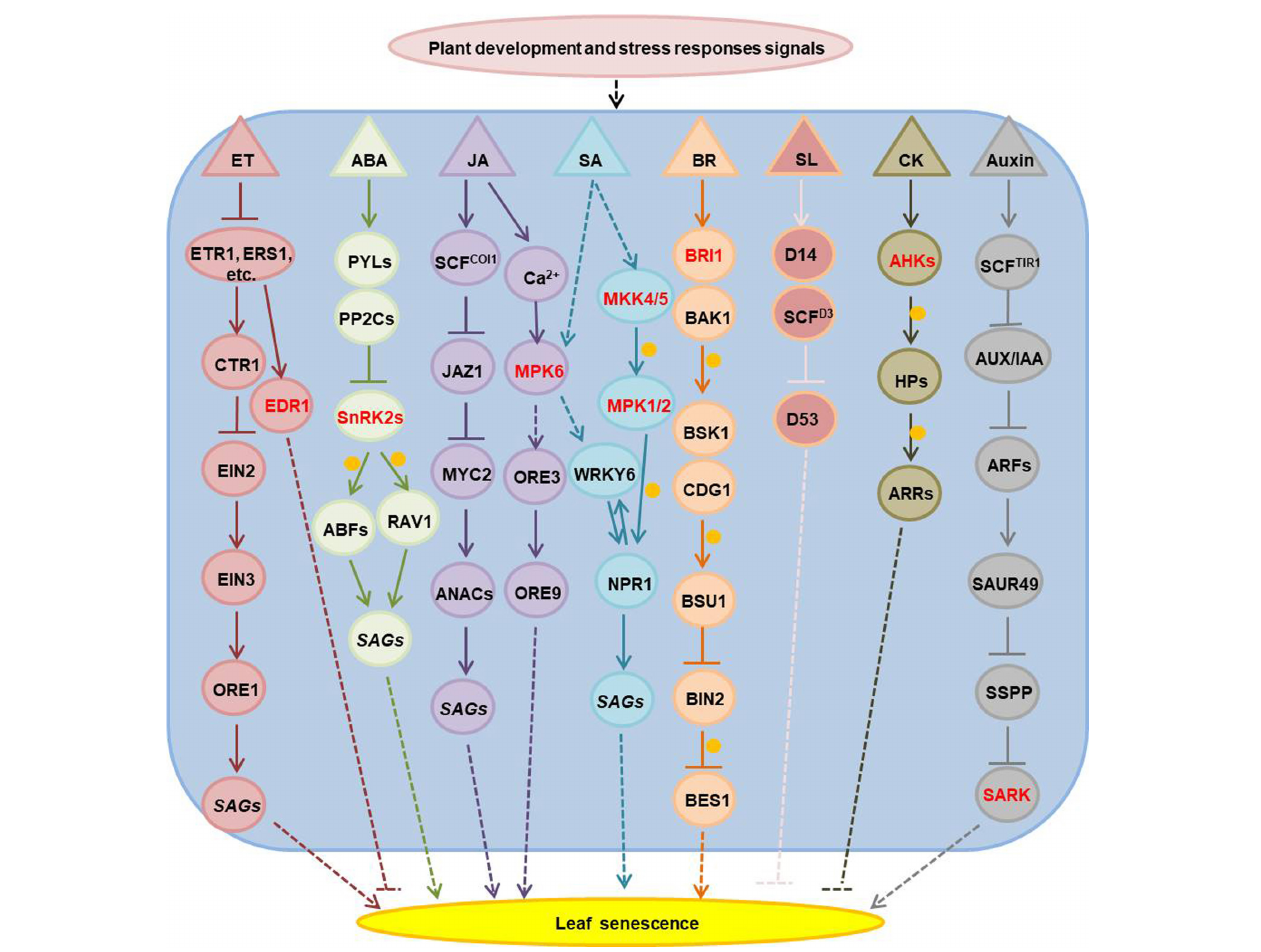
FIGURE 1 | The senescence-associated kinases functioned in hormones-regulated leaf senescence. The kinases are marked with red; arrows show that the process is promoted, and T-bars mean the process is inhibited; the solid lines indicate direct reported relationship, and the dotted lines indicate indirect reported relationship; the orange circles indicate phosphorylation. ET, ethylene; ABA, abscisic acid; JA, jasmonic acid; SA, salicylic acid; BR, brassinosteroids; SL, strigolactone; CK, cytokinins; ETR1, ethylene response 1, it is one of the five ET receptors; ERS1, ethylene response sensor 1, one of ET receptors; CTR1, constitutive triple response 1, homologous to the RAF family of serine/threonine protein kinases, a negative regulator in the ethylene signal transduction pathway, it interacts with the putative ethylene receptors ETR1 and ERS1; EIN2, ethylene insensitive 2, it acts downstream of CTR1 to regulate EIN3 positively; EIN3, ethylene-insensitive 3, a nuclear transcription factor that initiates downstream transcriptional cascades for ethylene responses; ORE1, ORESARA 1, it is a NAC-domain transcription factor and regulates senescence in leaves positively; SAGs , senescence associated genes; EDR1, enhanced disease resistance 1, a RAF family of serine/threonine protein kinases like CTR1, it has a negative role in ET signal pathway; PYLs, pyrabactin resistance 1-like family proteins, function as the ABA receptors; PP2Cs, the type 2C protein phosphatases, function as ABA co-receptors; SnRK2s, sucrose non-fermenting 1-related protein kinase 2 family proteins, they are activated by ABA and inhibited by PP2Cs; ABFs, ABA responsive element binding factor proteins, as leucine zipper transcription factors that bind to the ABA-responsive element (ABRE) motifs in the promoter region of ABA-inducible genes; RAV1, related to ABI3/VP1 1, an AP2/B3 domain transcription factor which is upregulated in ABA-induced leaf senescence; COI1, coronatine insensitive 1, JA receptor, it associates with AtCUL1, AtRbx1, and the Skp1-like proteins to assemble SCF COI1 ubiquitin-ligase complexes; JAZ1, jasmonate-zim-domain protein 1, it is degraded by SCF COI1 ubiquitin-ligase complexes under JA stimulus; MYC2, MYC-related transcriptional activator 2; ANACs, NAC domain-contained transcription factors; MPK6, mitogen-activated protein kinase (MAPK) 6; ORE3, ORESARA 3 or named as EIN2; ORE9, ORESARA 9, as a member of the F-box leucine-rich repeat family proteins, it is a proposed regulator of leaf senescence; MKK4/5, MAPK kinase 4/5; MPK1/2 (MAPK1/2), mitogen-activated protein kinase 1/2; BRI1, BR insensitive 1, encodes a plasma membrane localized leucine-rich repeat receptor kinase, as BR receptor; BAK1, BRI1-associated receptor kinase, as the BR co-receptor with BRI1, it is a leucine-rich receptor serine/threonine protein kinase; BSK1, BR-signaling kinase 1; CDG1, constitutive differential growth 1, is a receptor-like cytoplasmic kinase, belongs to RLCKVII subfamily; BSU1, BRI1 suppressor 1, encodes a serine-threonine protein phosphatase; BIN2, brassinosteroid-insensitive 2, a member of the ATSK (shaggy-like kinase) family; BES1, BRI1-EMS-suppressor 1, a key transcription factor involved in BR signaling, coordinates plant growth and stress responses; D14, is a receptor in the SL signaling pathway; SCF D3 , as a member of the F-box leucine-rich repeat family of proteins, they are involved in SCF-dependent protein ubiquitination; D53, interacts with D14 in an SL-dependent manner, and it is shown to be degraded through the 26S proteasome pathway in a manner that requires the function of the F-box protein D3; AHKs, Arabidopsis histidine kinases, CK receptors, including AHK2, AHK3, and AHK4; HPs, histidine-containing phosphotransfer proteins; ARRs, Arabidopsis response regulators, including type-A and type-B ARR; TIR1, transport inhibitor response 1, encodes an auxin receptor, it contains leucine-rich repeats and an F-box and forms SCF (Skp-Cullin-F-box) complexes with ASK1 and CUL1; AUX/IAA, repressors of auxin-responsive transcription; ARFs, auxin-response factors; SAUR, small auxin upregulated RNA; SSPP, senescence suppressed protein phosphatase; SARK, senescence-associated receptor-like kinase.